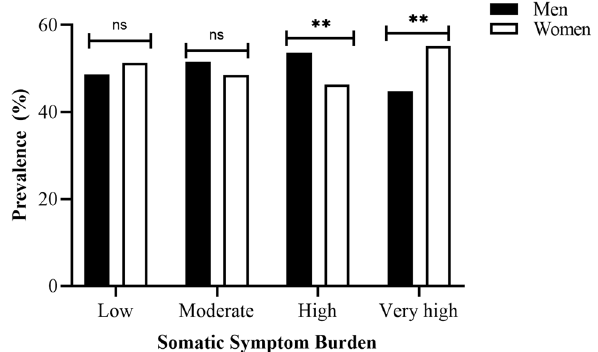
Figure 1. Prevalence of somatic symptom burden reported in men (n = 5861) and women (n = 5679) of the MONICA/KORA population-based cohort (N = 11,540).